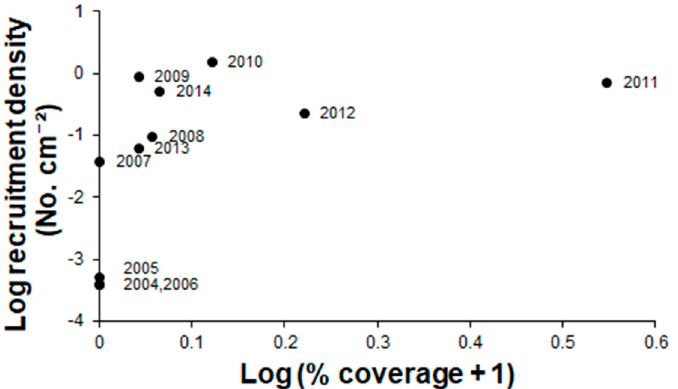
Figure 3. Temporal variations in the relationship between mean coverage and mean annual recruitment density of Balanus glandula in eastern Hokkaido during 2004–2014. Table 1. Moving-window regression statistics of the log of annual recruitment density against the log of mean coverage on a regional scale at window widths of 5, 6, 7, and 8 years Temporal Extent of Data Applying n for Regression Analysis Regression R 2 P value coefficient